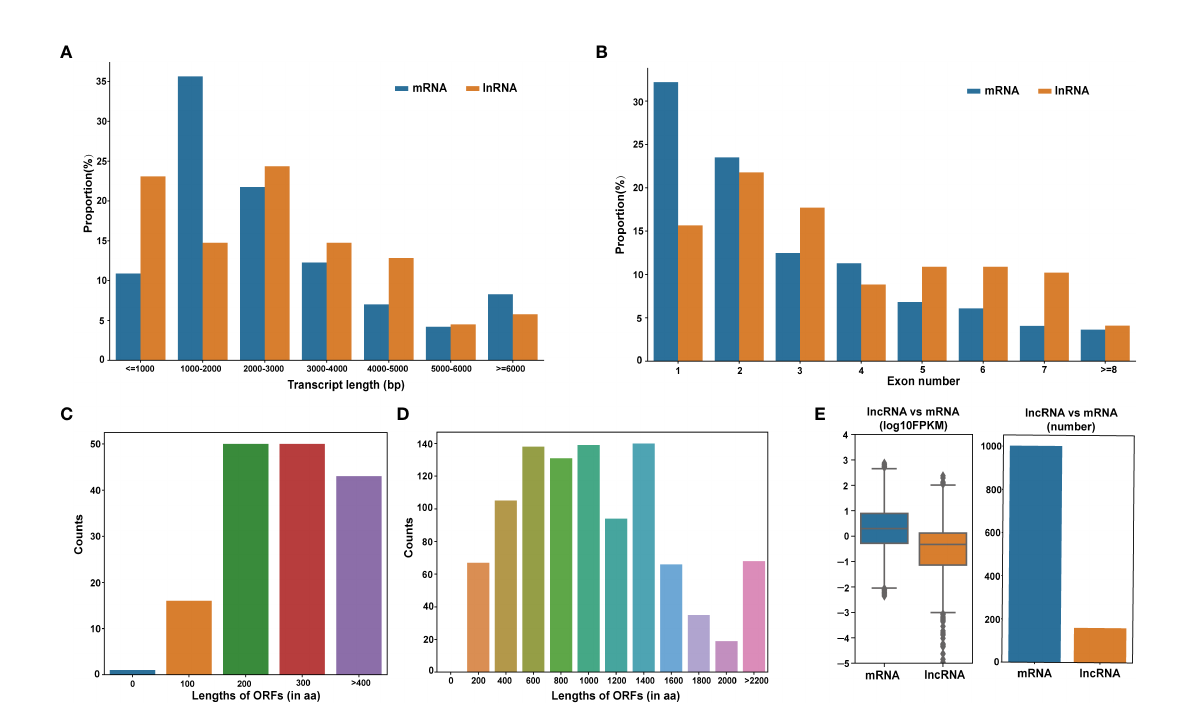
FIGURE 4 Evaluation of the DE-lncRNA and DE-mRNA structural and expression pro fi les. (A) DE-lncRNAs and DE-mRNAs transcript length distributions. (B) Structural comparison between lncRNAs and mRNAs in terms of exon number. (C, D) Open reading frames (ORF) length distribution of DE-lncRNAs and DE-mRNAs. (E) DE-lncRNA and DE-mRNA expression levels. DE-lncRNAs, differentially expressed long-coding RNAs; DE-mRNAs, differentially expressed